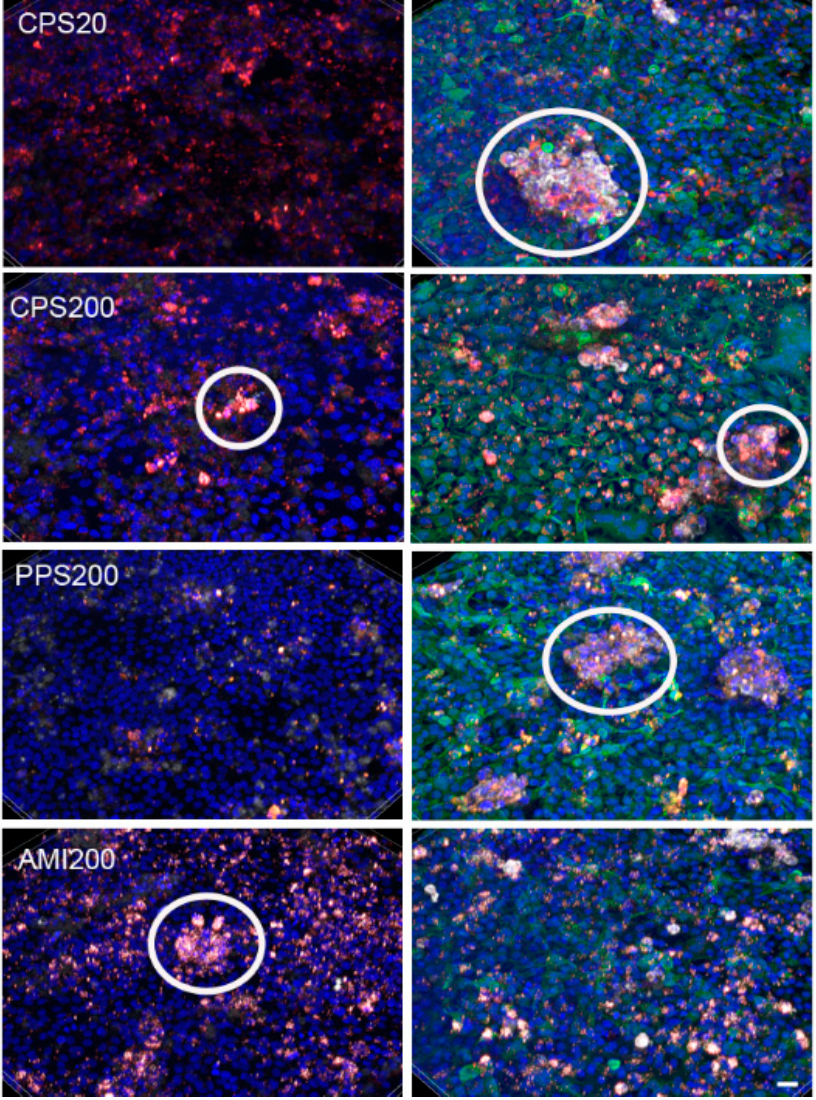
Figure 9. 3D projection of z-scan showing particle uptake (red) at d1 and d7 in A549/THP-1 co-cultures. In the left column (d1), only THP-1 cells are stained by CD45 antibody (white). In the right column (d7), in addition to THP-1 macrophages, A549 cells are identified by anti-CK18 immunoreactivity (green). Examples for clusters of CD45-positive THP-1 cells are indicated by circles. Scale bar: 20 µm.